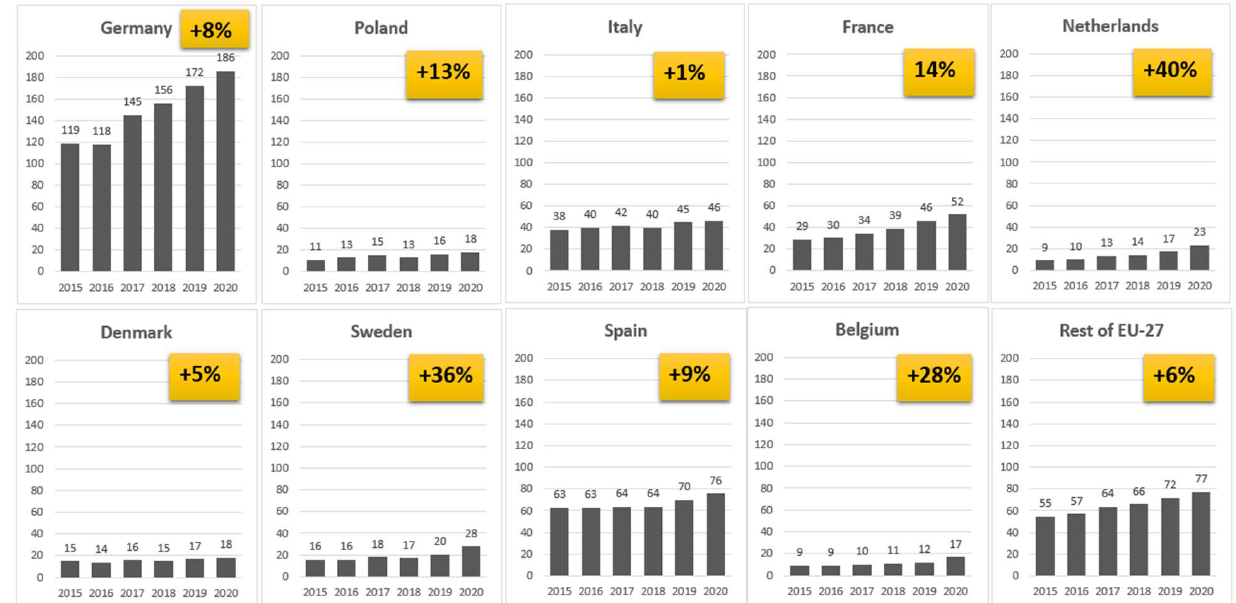
Figure 3. Wind and solar generation, percentage change from 2019 to 2020, source: own study based on [9].